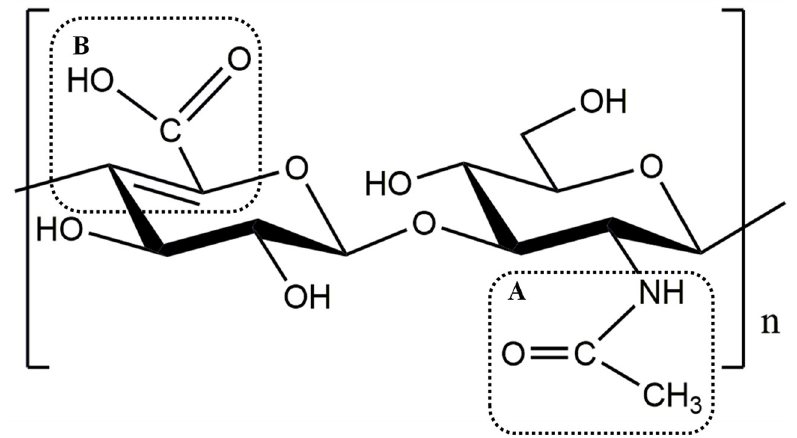
Figure 6. General structure of unsaturated hyaluronic acid oligosaccharide. GlcUA, D-glucuronic acid. GlcNAc, N-acetyl-D-glucosamine. ( A ) Acetylamino groups of GlcNAc; ( B ) conjugated double bond between Δ4,5-unsaturated bond and C 6 carboxyl groups of GlcUA.